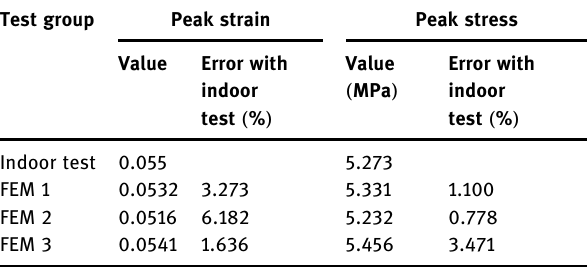
Table 9: Calculation of errors in numerical model calculation results Test group Peak